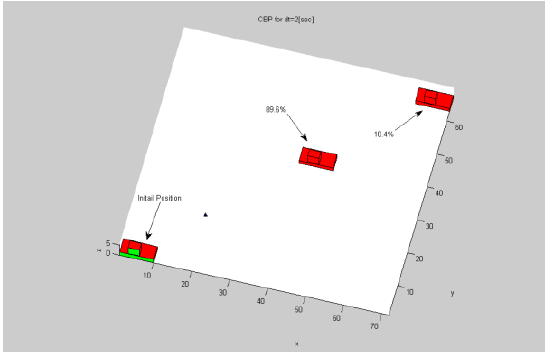
Figure 3. Probabilistic Visibility Analysis for CBP